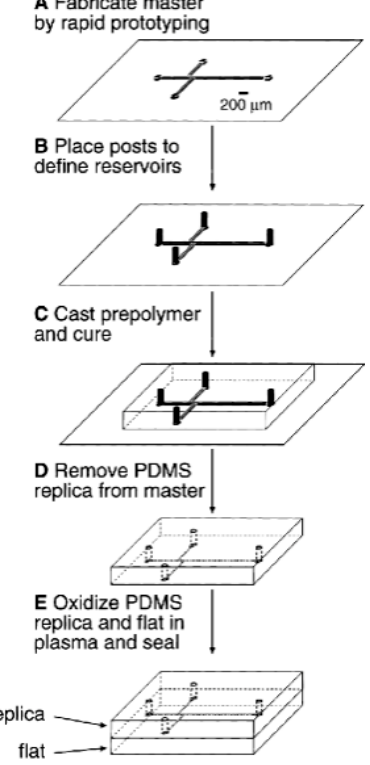
Figure 15. Schematic representation of micro-channel fabrication using soft lithography. ( A ) A high-resolution transparency containing the design of the channels, created in a CAD program, was used as the mask in photolithography to produce a positive relief of photoresist on a silicon wafer. The scale bar gives an indication of the thickness and width of photoresist. ( B ) Glass posts were placed on the wafer to define reservoirs for analytes and buffers. ( C ) A prepolymer of PDMS was then cast onto the silicon wafer and cured at 65 °C for 1 h. ( D ) The polymer replica of the master containing a negative relief of channels was peeled away from the silicon wafer, and the glass posts were removed. ( E ) The PDMS replica and a flat slab of PDMS were oxidized in a plasma discharge for 1 min. Plasma oxidation had two effects. First, when two oxidized PDMS surfaces were brought into conformal contact, an irreversible seal formed between them. This seal defined the channels as four walls of oxidized PDMS. Second, silanol (SiOH) groups introduced onto the surface of the polymer ionize in neutral or basic aqueous solutions and support EOF in the channels. Taken with permission from [131].